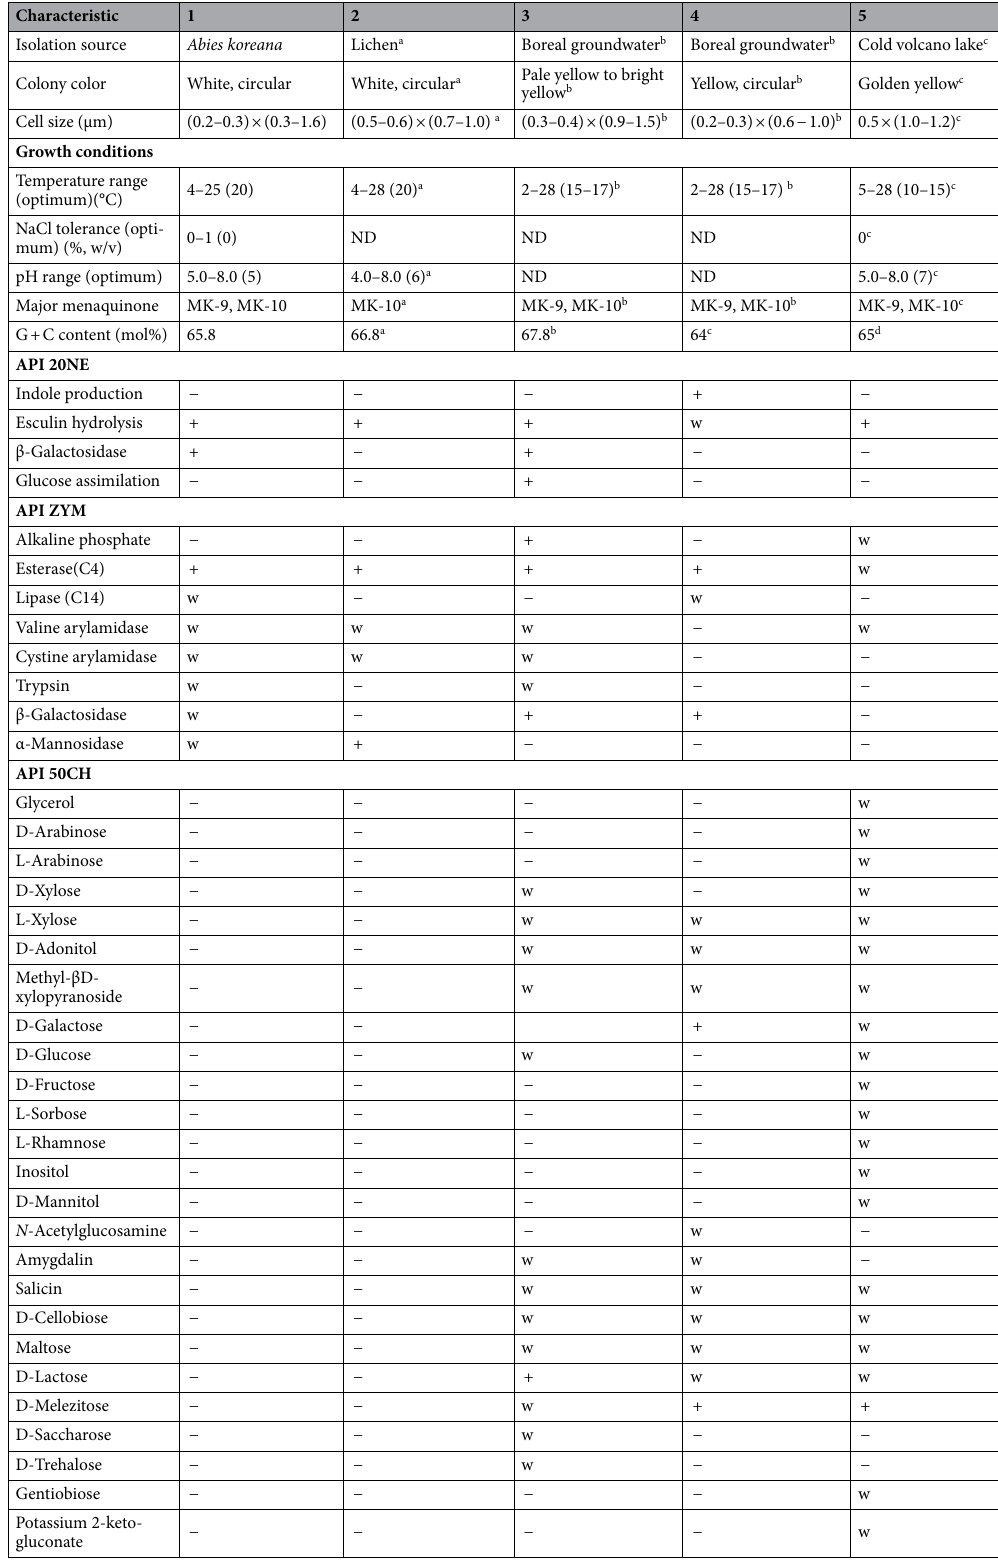
Table 1. Differential phenotypic characteristics that distinguish strain AK-R2A1-2 T from closely related type strains. Strains: 1, AK-R2A1-2 T ; 2, Subtercola lobariae KCTC 33586 T ; 3, Subtercola frigoramans KCTC 49696 T